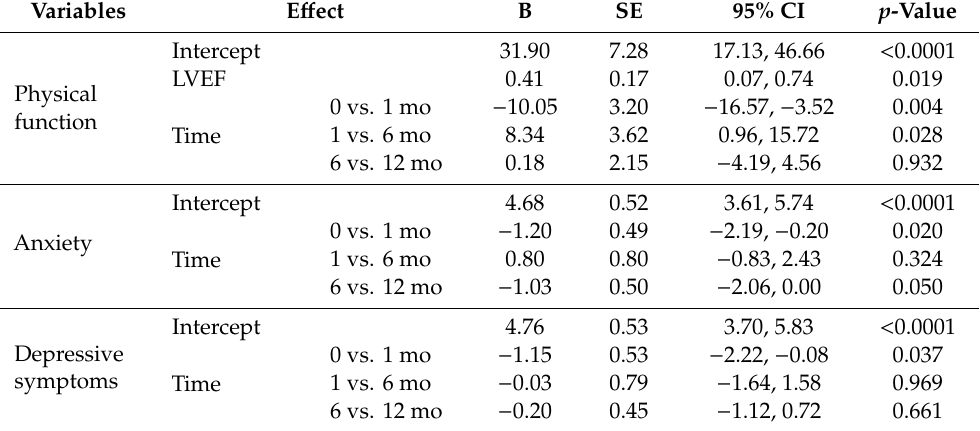
Table 3. Mixed Modeling Procedures: Time Effects on Pre-Implant-to 1, 6, and 12 months Post- Implant Changes in Physical Function and Psychological Distress of Defibrillator Recipients.